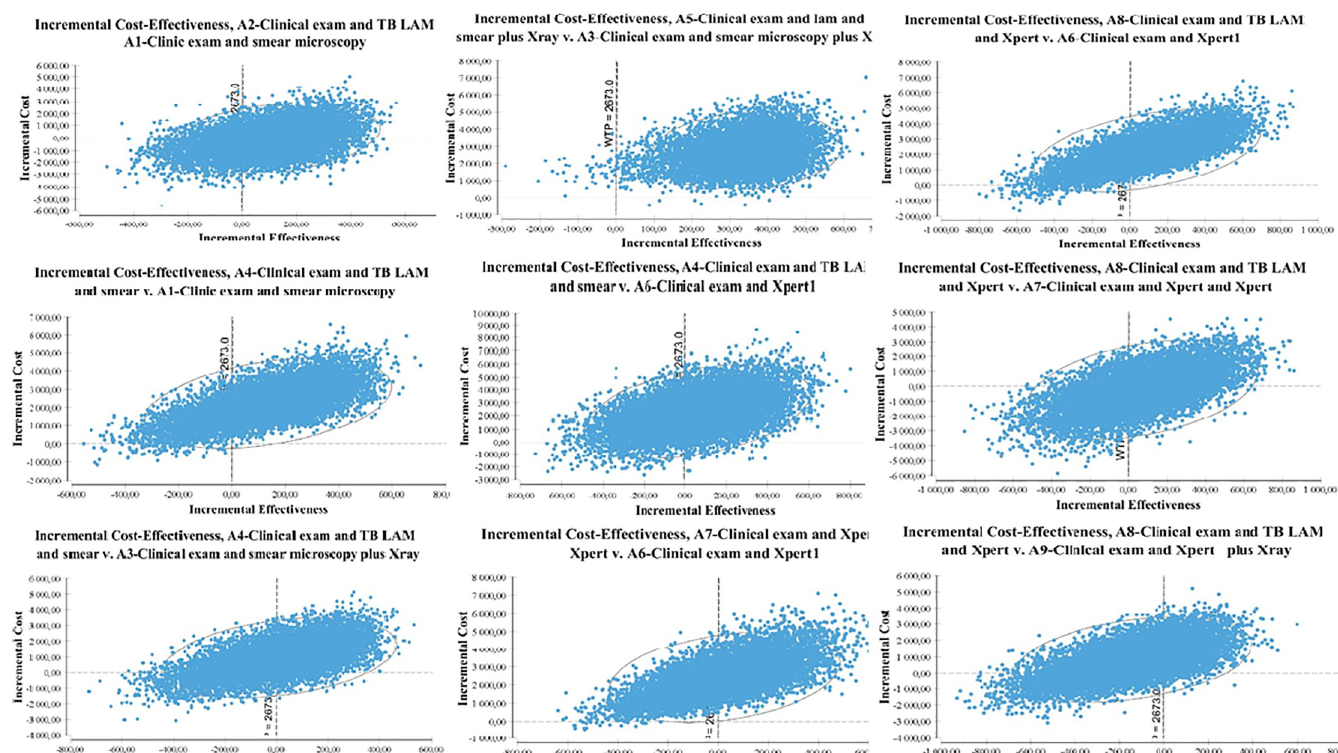
Fig 2. Cost-effectiveness planes. This graph represent the differences in costs and DALYs between algorithms. DALYs are plot on the x axis and costs on the y axis. Results in costs and differences in DALYs averted observed in the 10, 000 bootstrap replicates.